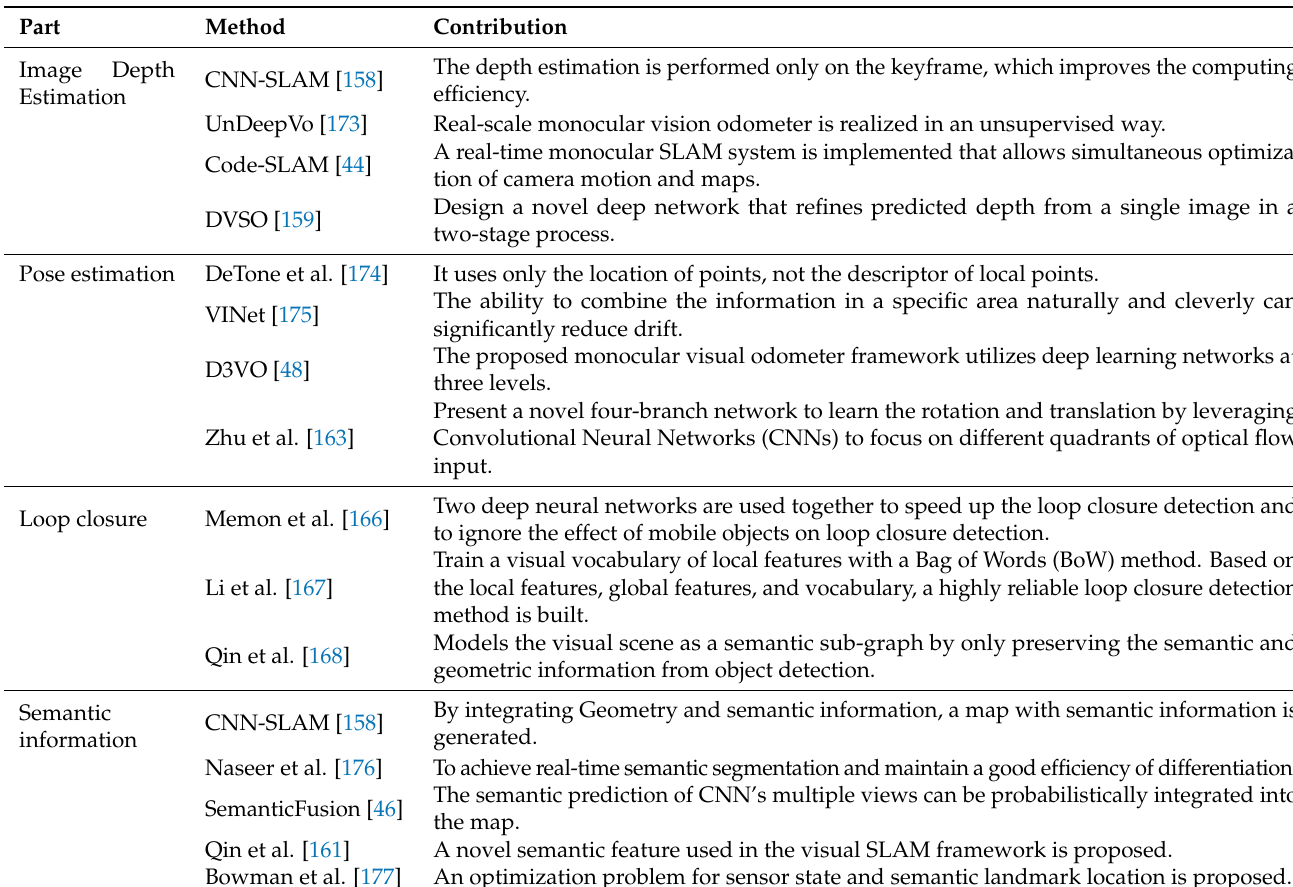
Table 8. CNN used for